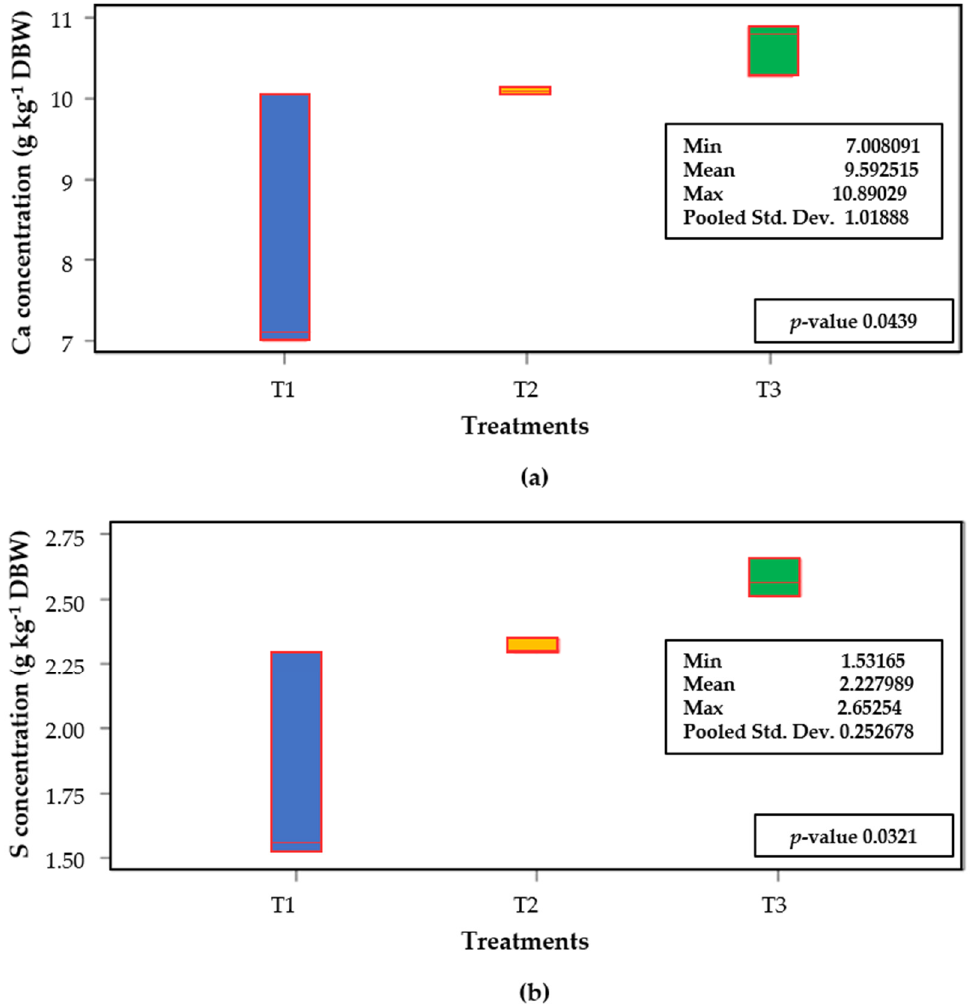
Figure 5. Box diagram of Ca ( a ) and S ( b ) concentrations in leaves of lulo ( Solanum quitoense Lam.) seedlings grown in different combinations of peatmoss and compost. Data of five samples (each composed sample was derived from two repetitions per treatment). Wilcoxon’s rank summation test ( p ≤ 0.05). Treatments are as follows (percentage of peatmoss/compost, v / v ): T1: 60/40; T2: 40/60; T3: 20/80.